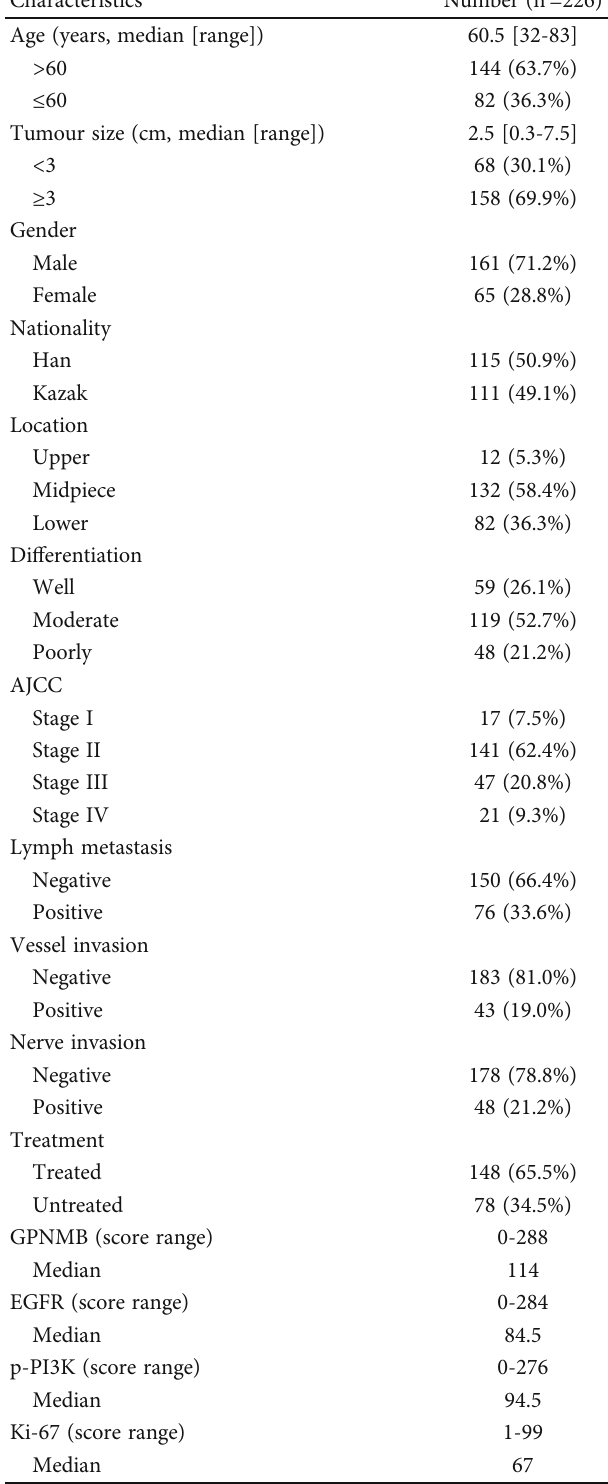
Table 1: General characteristics of ESCC